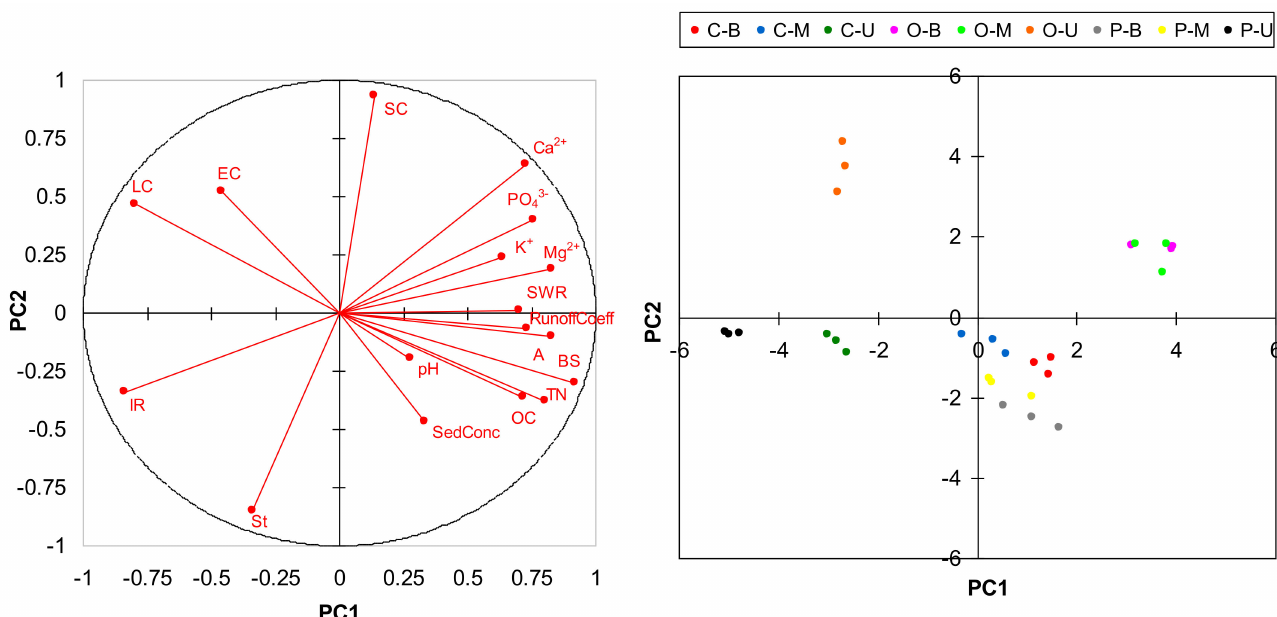
Figure 3. Loadings of the original variables ( left , soil covers and properties, and hydrological variables), and scores ( right ) on the first two Principal Components (PC1 and PC2) provided by PCA in the experimental sites immediately after the prescribed fire and mulching treatment (Samo, Calabria, Southern Italy). Legend: P = pine; C = chestnut; O = oak; U = unburned; B = burned and not treated; M = burned and mulched; RunoffCoeff = runoff coefficient; SedConc = sediment concentration; SWR = soil water repellency; IR = infiltration rate; BS = bare soil; LC = litter cover; SC = shrub cover; A = ash; St = stoniness; EC = electrical conductivity; OC = organic carbon; TN = total nitrogen; PO 43- = phosphates; K + = potassium; Mg 2+ = magnesium; Ca 2+ = calcium.